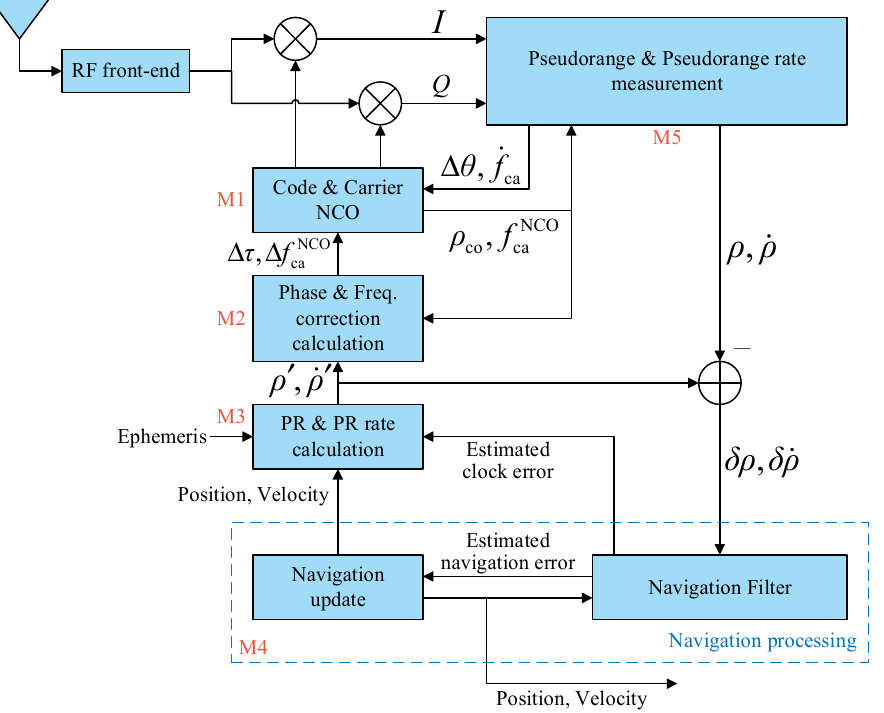
Figure 2. Implementation framework of vector tracking loop.